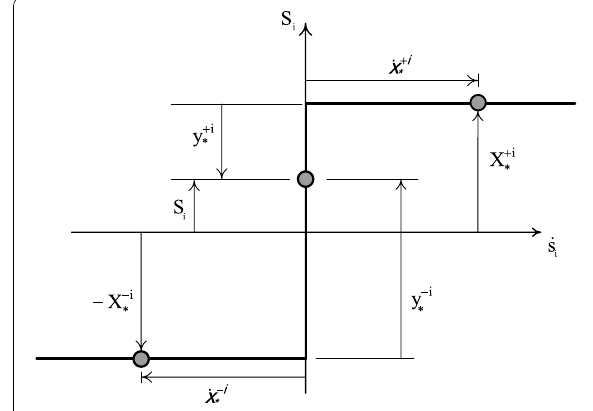
Fig. 4 Variables describing a simple flexural plastic